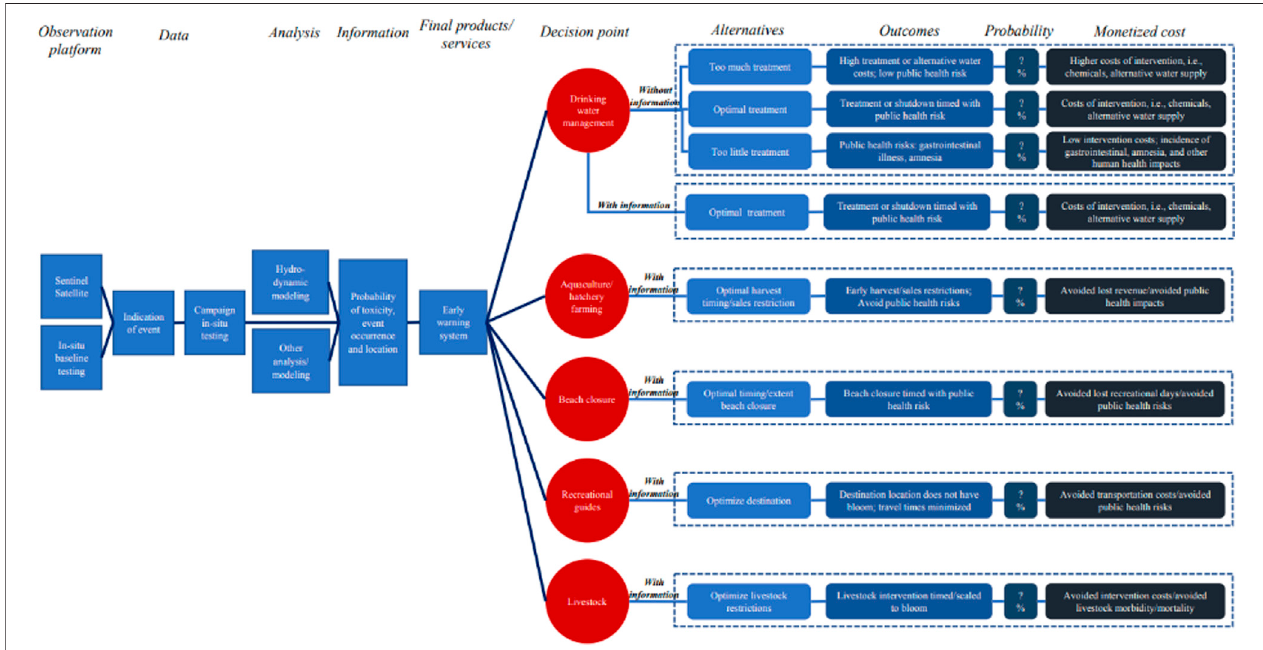
FIGURE 1 | Conceptual cyanobacteria harmful algal bloom value chain and decision tree. From Pearlman et al. (2019) public domain.